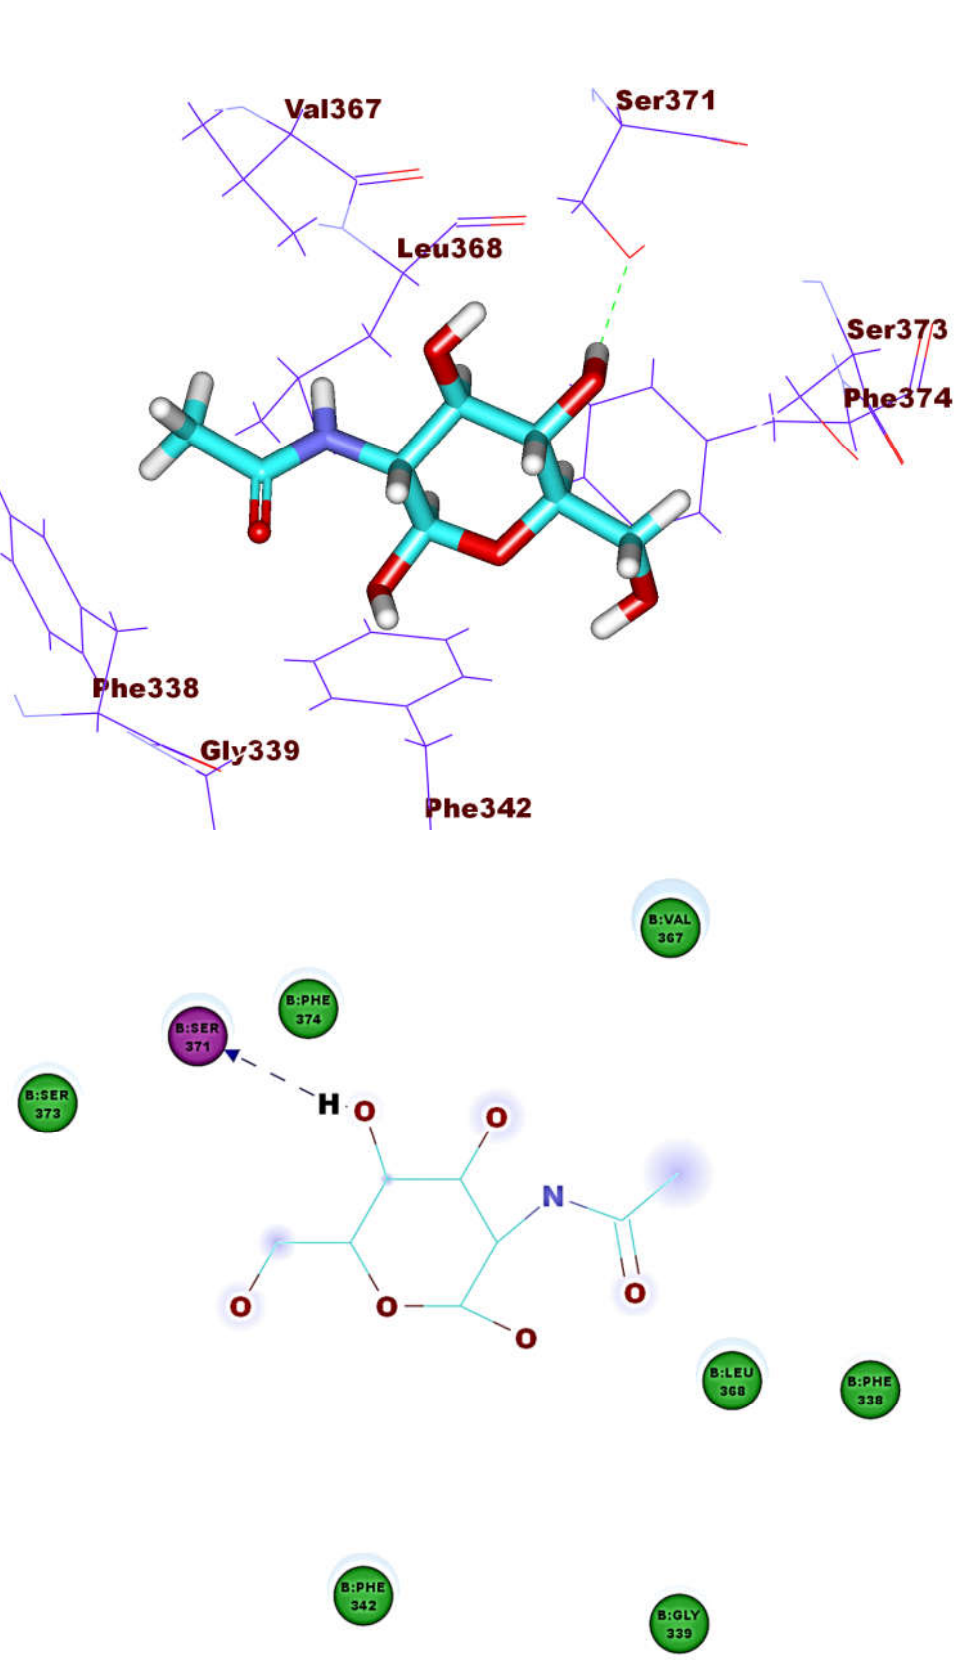
Figure 4. The co-crystallized ligand (NAG) docked into ACE-2, forming one H. bond with Ser371.